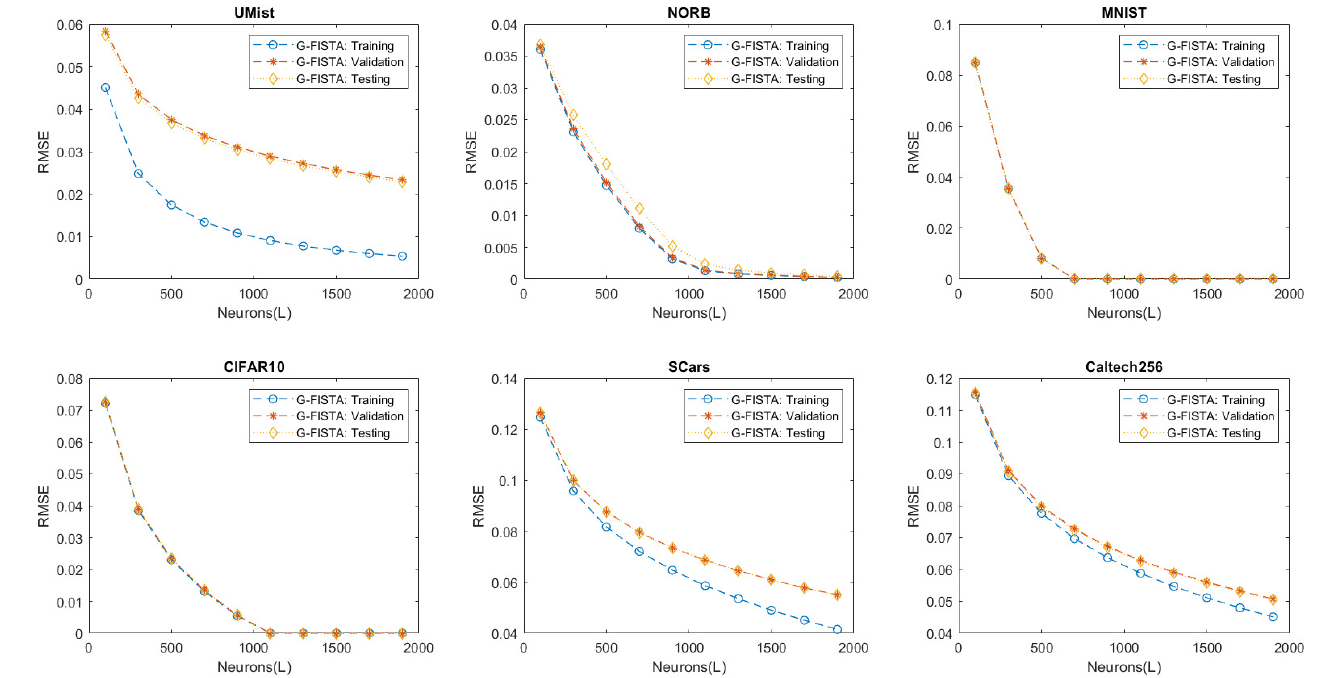
Figure 1. G-FISTA Algorithm: plot of RMSE for training, validation, and testing sets versus the number of